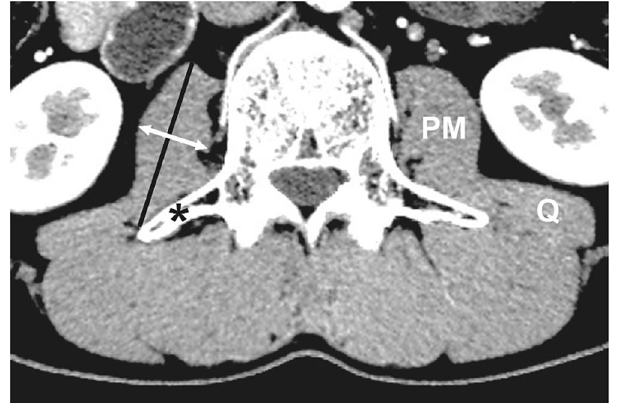
Figure 6. Psoas muscle measurement with a cross-sectional CT image. White arrow, psoas muscle thickness (PMT); black line, antero-posterior axis of the psoas muscle; asterisk, the transverse process of the 3rd lumber vertebra; Q, quadratus lumborum